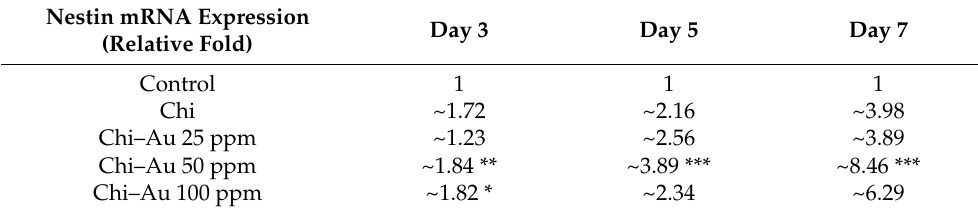
Table 3. Nestin mRNA expression at 3, 5, and 7 days.